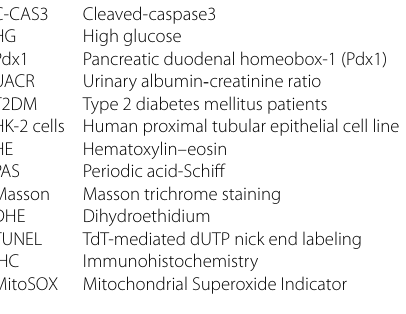
3. Figure S2. Representative IHC images of = negative controland antibody staining. HSP60, LONP1and their negative control of IHC staining in db/m and db/db mice.